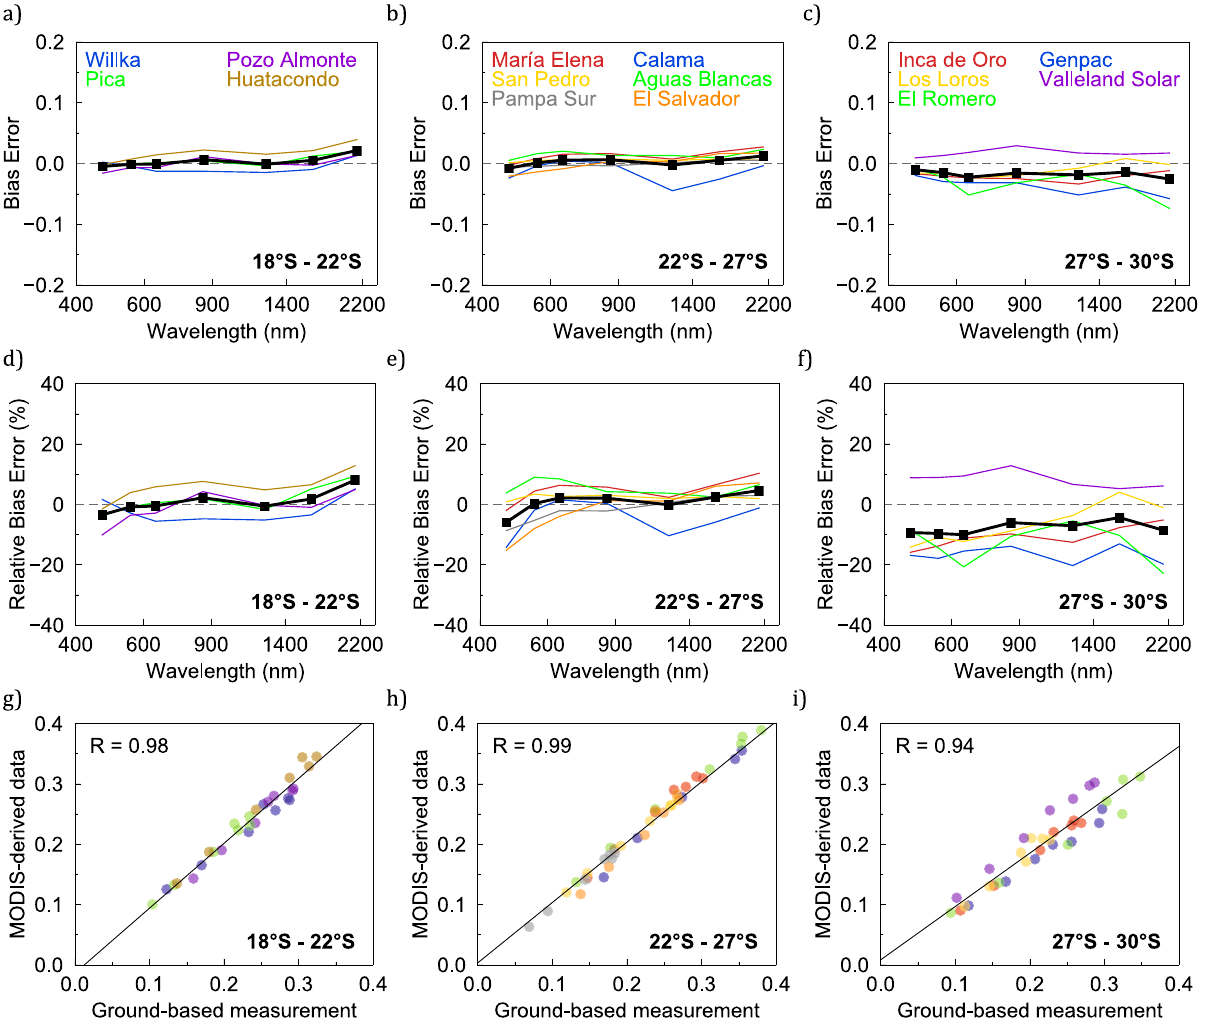
Figure 3. Comparison between MODIS-derived estimates of the blue-sky albedo and ground-based measurements of the albedo (taken as reference). ( a–c ) Bias error (thick line stands for the mean bias error), ( d–f ) Relative bias error (thick line stands for the relative mean bias error), ( g–i ) Scatter plots (correlation coefficients R are shown in the plots). For the comparisons, sites were clustered according to the latitude: from latitude 18° S to latitude 22° S (left-hand column), from latitude 22° S to latitude 27° S (central column) and from latitude 27° S to latitude 30° S (right-hand column). In plots ( a–f ), dots indicate the center of the MODIS bands. Plots were generated by using Python’s Matplotlib Library 44